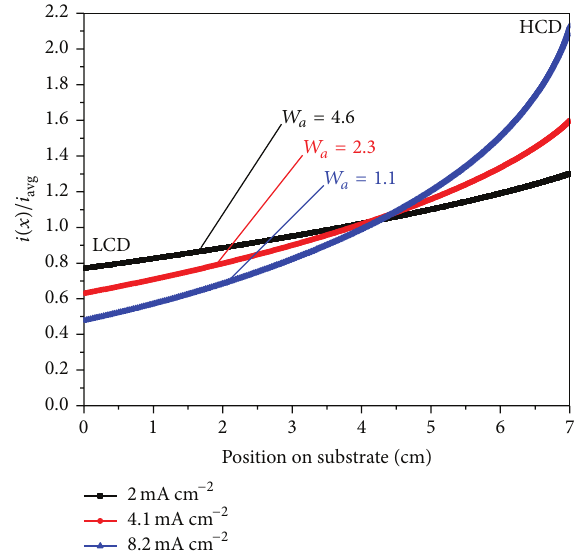
Figure 9: Secondary current distribution for modified Hull cell during Cu electrodeposition carried out at different applied average current densities of 2, 4.1, and 8.2 mAcm −2